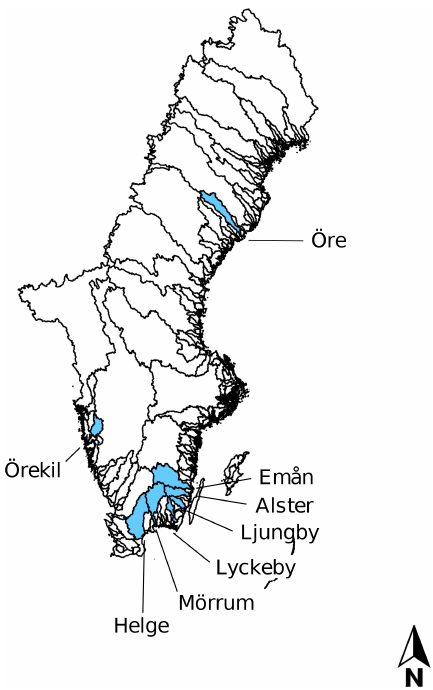
Figure 1. Map of all river catchments in Sweden with the ones con- sidered in this study named and marked